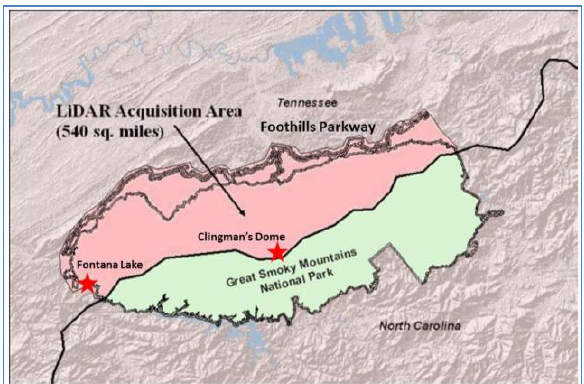
Figure 1 : The Great Smoky Mountains National Park (GRSM) straddles the border of North Carolina and Tennessee in the Blue Ridge Mountains. LiDAR data were acquired for the Tennessee portion of GRSM and the adjacent Foothills Park- way, a total area of 1400 sq. km. (540 sq.